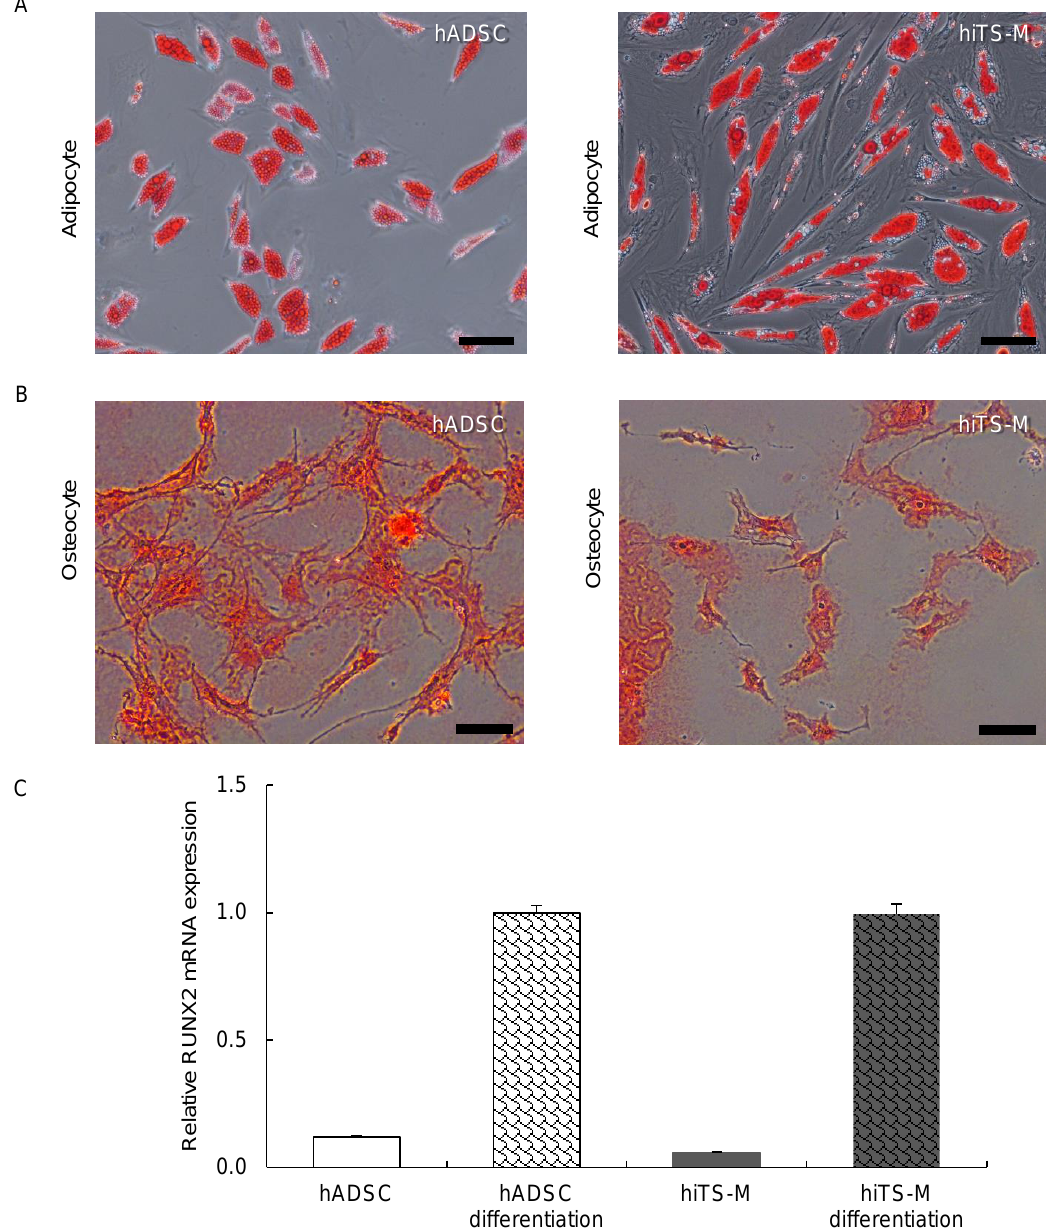
Figure 4. Differentiation of hiTS-M cells into adipocytes and osteocytes. Differentiation of hADSCs and hiTS-M cells into ( A ) adipocyte and ( B ) osteocytes. hADSCs (passage 3) and hiTS-M cells (passage 14 + 4) were used. Scale bars = 100 µ m. ( C ) qRT-PCR analysis of RUNX2 expression in hADSCs (passage 5) and hiTS-M cells (passage 14 + 5). Data are expressed as RUNX2 -to- GAPDH ratios, with the ratio of differentiated hADSCs arbitrarily defined as one ( n =